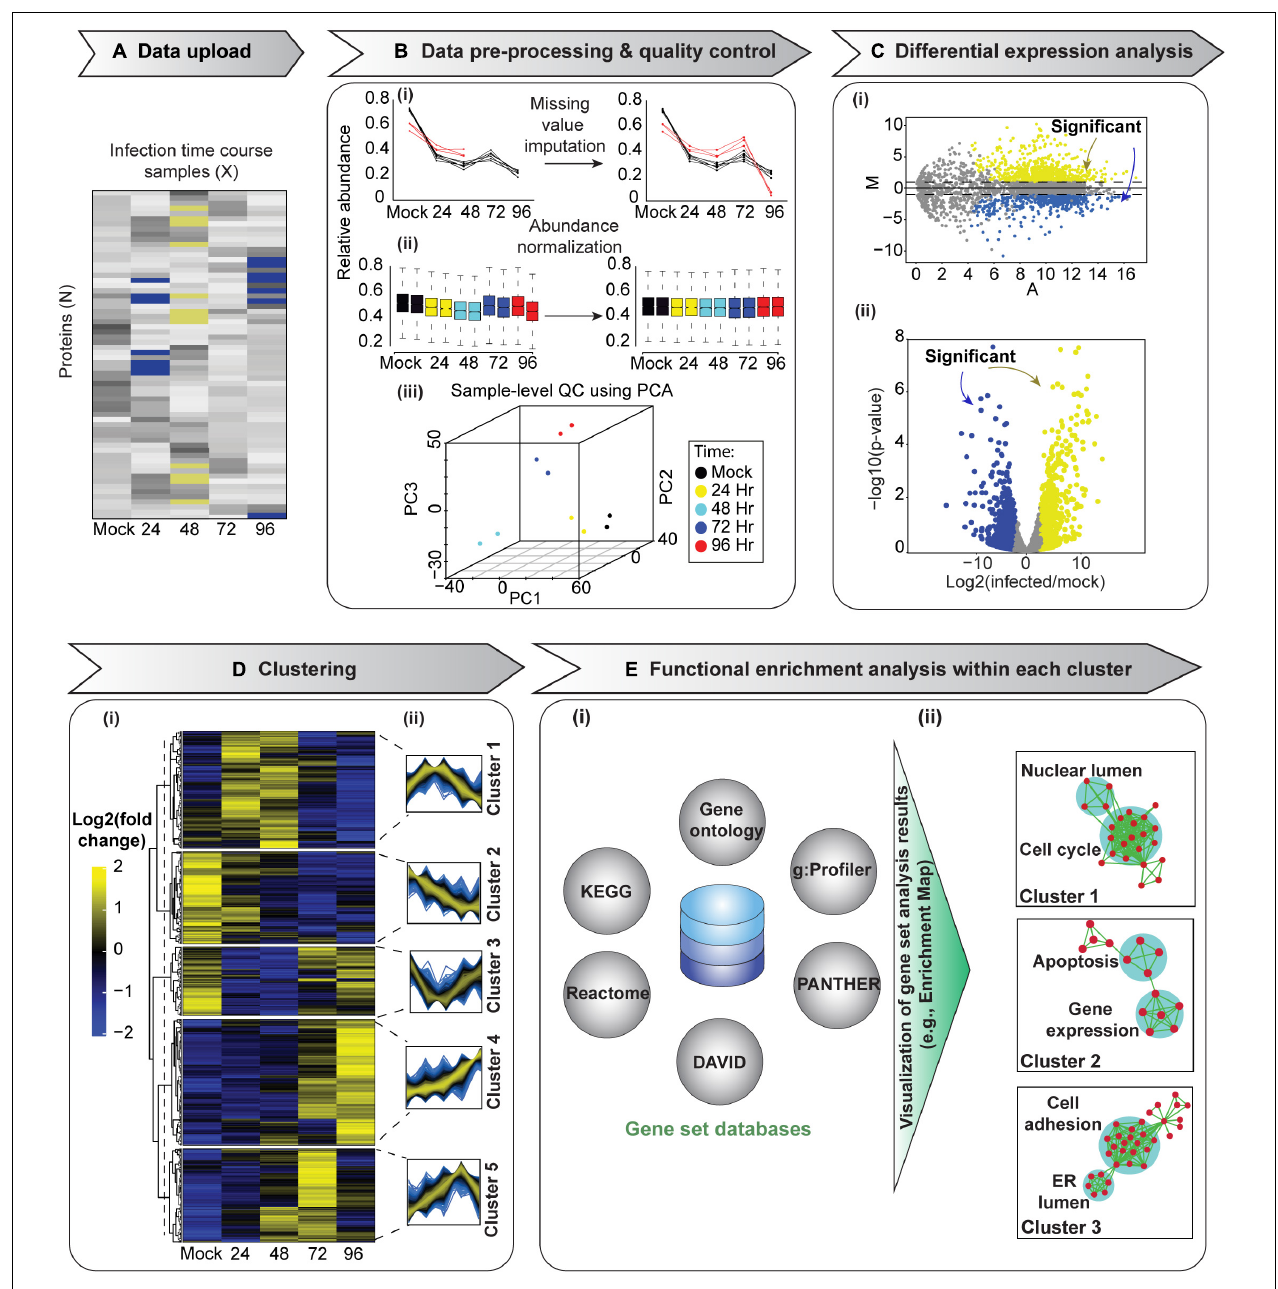
FIGURE 2 | A schematic of temporal proteomic data analysis pipeline. After upload (A) , data pre-processing and quality control steps are performed (B) . These include the imputation of missing values (i), normalization (ii), and sample-level quality control, e.g., using principal component analysis (PCA, iii). (C) Differential expression analysis can then be performed to identify proteins with significantly altered expression between states, for example, different relative (infected/mock) expression between time points. Results can be visualized in (i) an MA plot [log fold change, M, vs. log of the mean expression level between conditions, ( A )] or in (ii) a volcano plot. Subsequently, clustering analysis can be performed to group proteins with similar temporal expression patterns (D) . Here, we applied hierarchical clustering, which is displayed in conjunction with a heat map visualization of the clustered data. The dendrogram was cut at the level indicated by the dashed line to yield five clusters. (ii) Each cluster’s temporal profiles can be visualized in a simple plot with relative abundances (y-axis) of proteins within each cluster across all time points (x-axis). Finally, functional enrichment analysis of each of these clusters could provide information on pathways and cellular processes rewired in response to an infection (E) . (i) Groups for the analysis can be derived from annotations (e.g., gene ontology; Gene Ontology Consortium, 2004), a pathway database (e.g., KEGG; Kanehisa et al., 2012, Reactome; Croft et al., 2011), or a combination of these (e.g., DAVID; Sherman et al., 2007, PANTHER; Mi et al., 2013, and g:Profiler; Reimand et al., 2007). (ii) Since many inter-dependent gene sets may be enriched, organizing results into a network, e.g., by means of EnrichmentMap (Merico et al., 2010) can be useful. Here, gene sets that share many proteins are grouped together, thereby offering an intuitive visualization of the results. We used 1,000 randomly selected proteins from Weekes et al. (2014) experiment 1 to exemplify data analysis